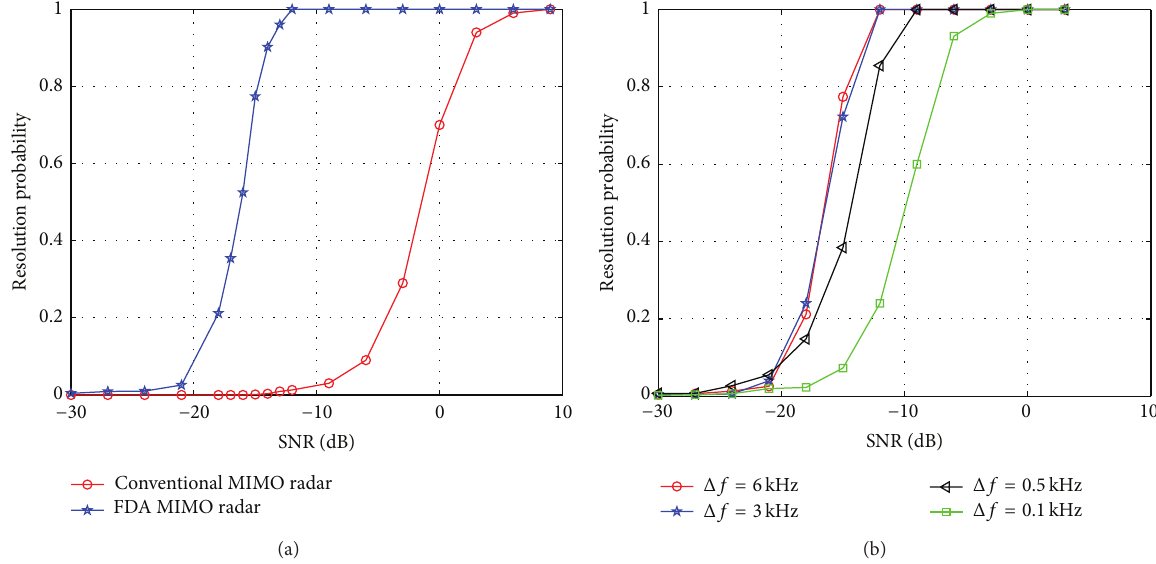
Figure 8: Resolution probability: (a) FDA MIMO radar and conventional MIMO radar and (b) different Δ𝑓 for FDA MIMO radar.